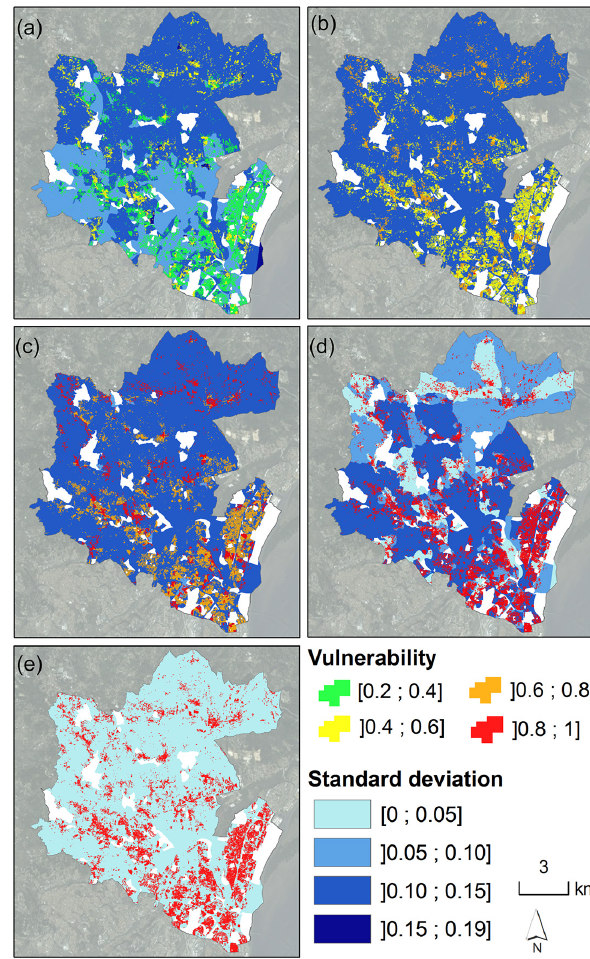
Figure 7. Average building vulnerability and standard deviation per BGRI subsection for buildings located on a landslide body, for a slip surface depth of (a) 1m, (b) 3m, (c) 5m, (d) 10m, and (e) 20m. White polygons are BGRI subsections without buildings.